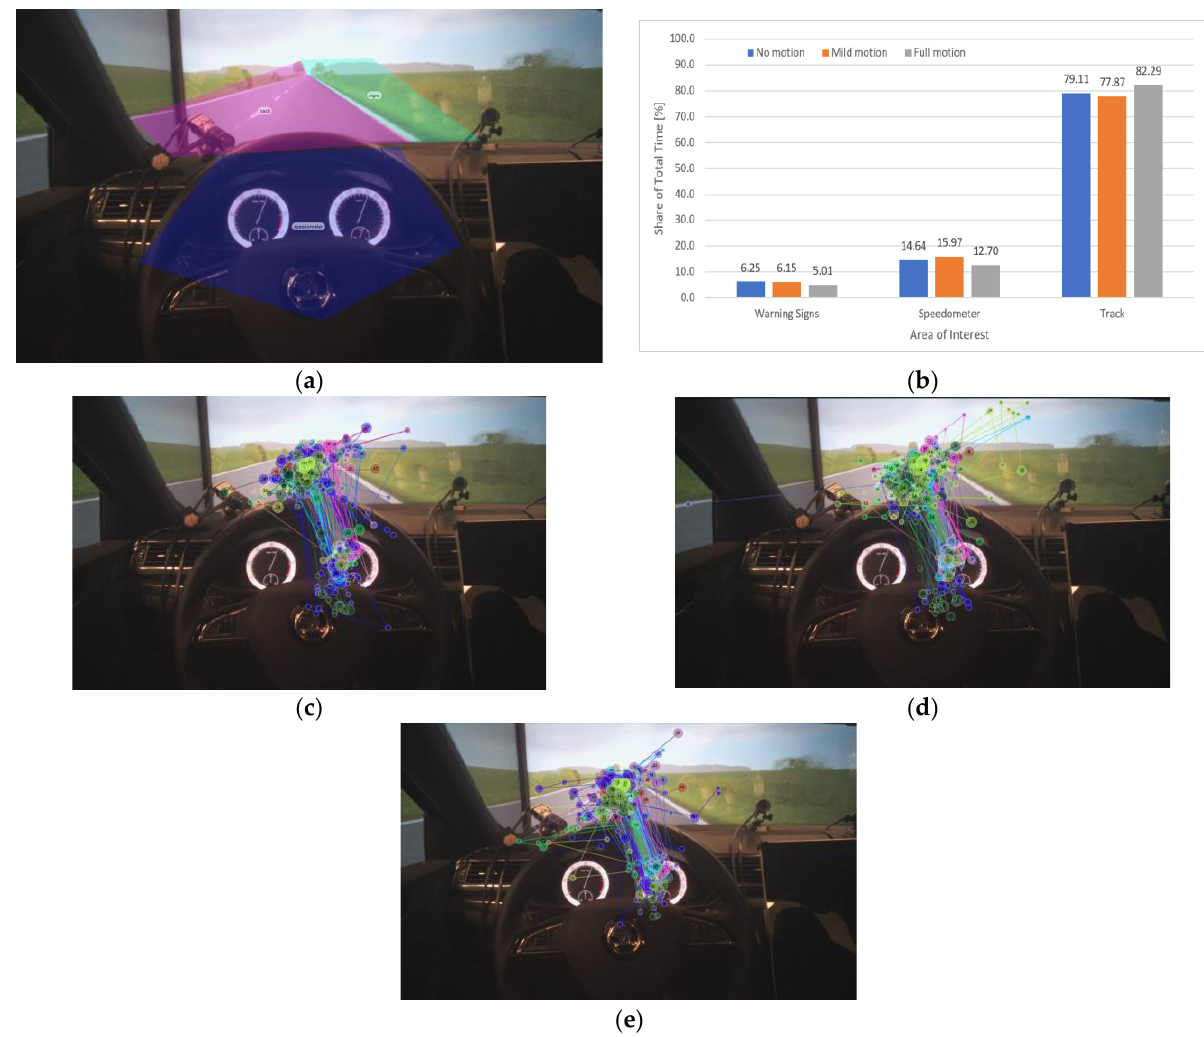
Figure 9. Eye tracker data analysis in the “With signs” scenario. ( a ) The area of interest (AOI) map consisting of the “Track” area highlighted in pink, the “Dashboard” area in blue and “Warning signs” angle in green. ( b ) The total share of time of gaze focus on the different AOIs under different motion conditions. ( c – e ) are the “Gaze Maps”, respectively, under “No Motion”, “Mild Motion”, and “Full Motion” conditions.